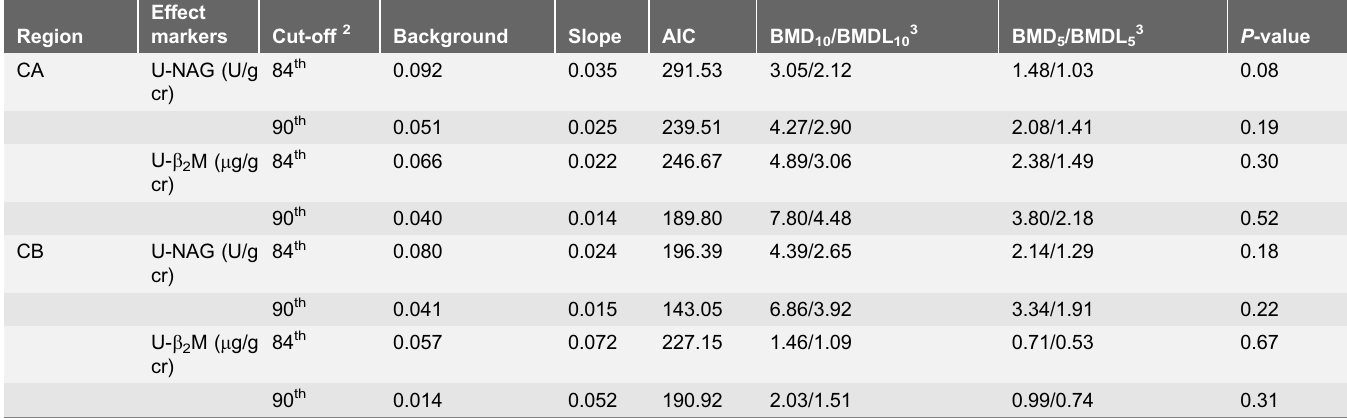
Table 7. Benchmark dose (BMD) estimates of U-Cd levels based on U- b 2 M and U-NAG using a quantal-linear model 1 .